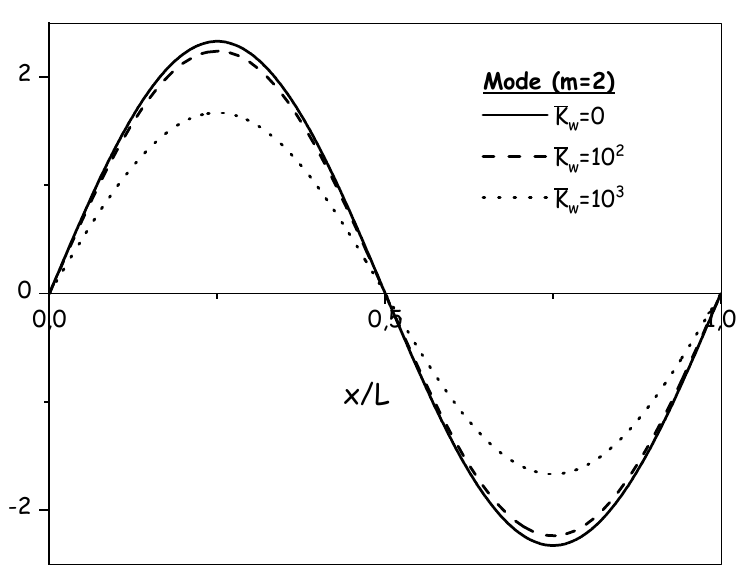
Figure 6: Mode shape of w at the base surface of the beam with various aspect ratios for the second mode frequency